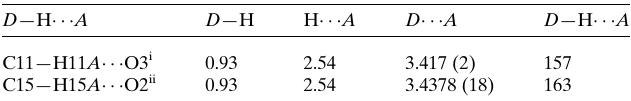
Table 1 Hydrogen-bond geometry (A˚ , (cid:2)